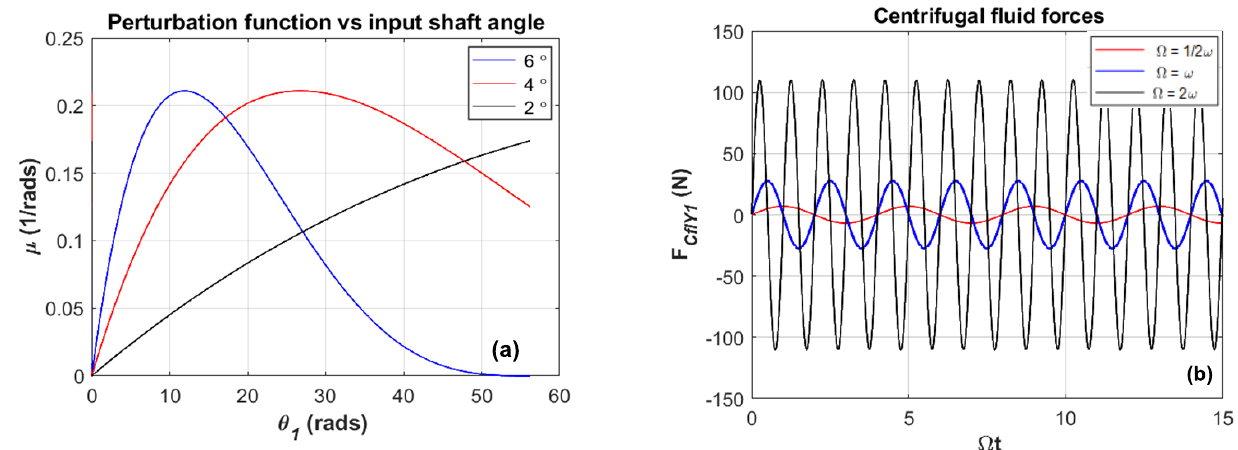
Figure 5. Rotor system fluctuation ( a ) driveshaft disturbance function profile in the fluid medium at a variable joint angle β = 6,4,2 ◦ ( b ) centrifugal fluid forces